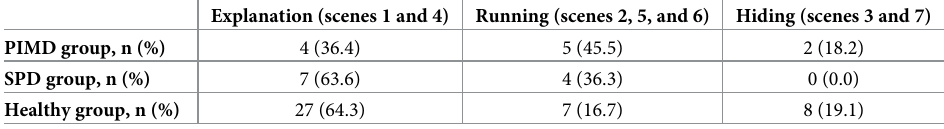
Table 2. Characteristics of study subjects’ group of the best distance score by each